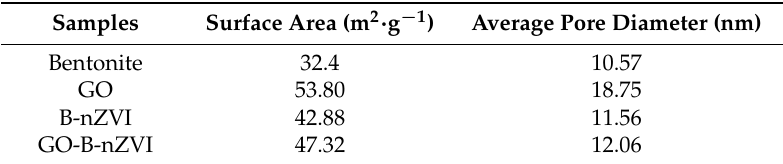
Table 2. The BET area of bentonite, GO, B-nZVI, and GO-B-nZVI.